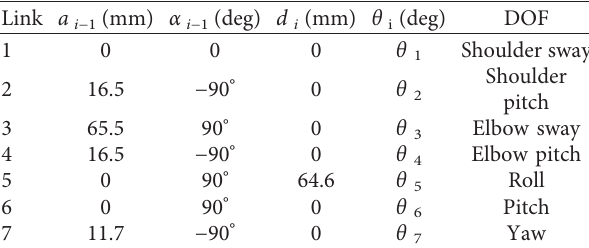
Figure 3: Design of the 7-DOF robotic arm. Table 1: D-H parameters of the proposed new design of 7-DOF robotic arm for